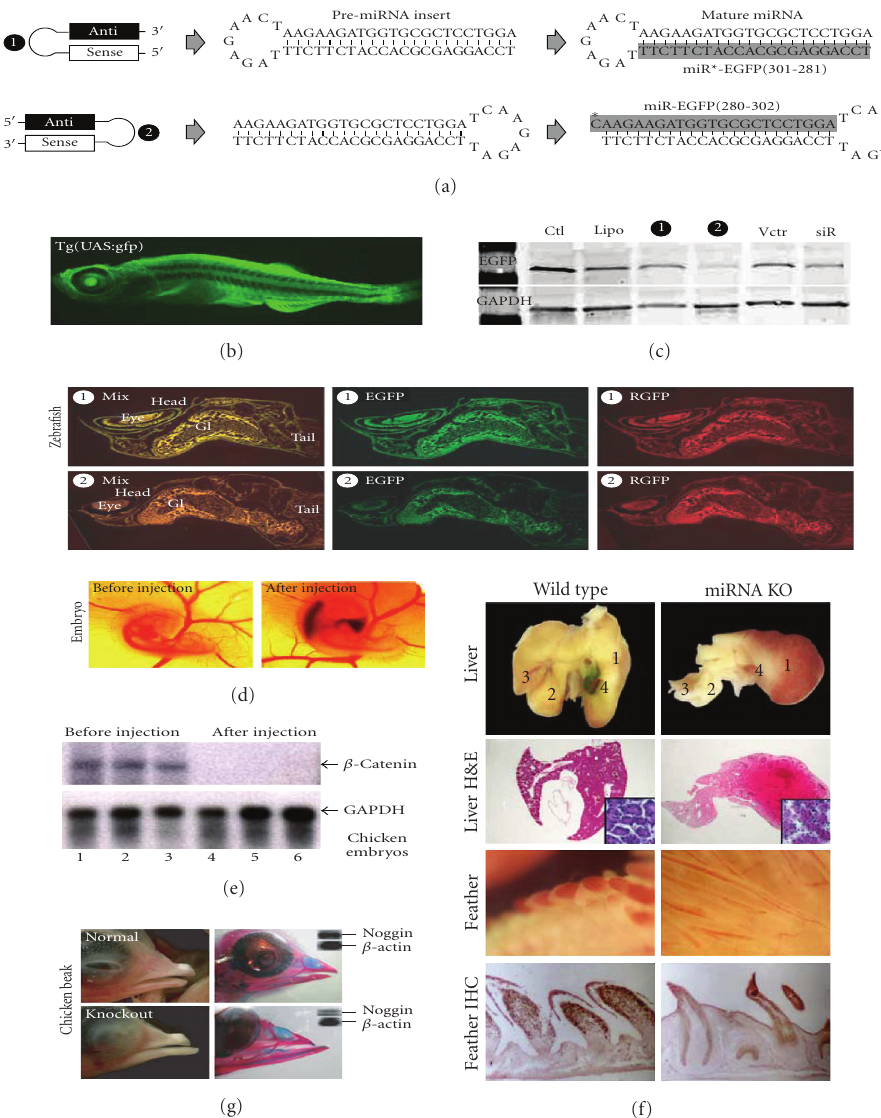
Figure 4: Intronic miRNA-mediated gene silencing e ff ects in vivo. (a)–(c) Di ff erent preferences for RISC assembly were observed following the transfection of 5 (cid:2) -miRNA ∗ -stemloop-miRNA-3 (cid:2) (1) and 5 (cid:2) -miRNA-stemloop-miRNA ∗ -3 (cid:2) (2) pre-miRNA structures in zebrafish, re- spectively. (a) One mature miRNA, namely miR-EGFP(280/302), was detected in the (2)-transfected zebrafish, whereas the